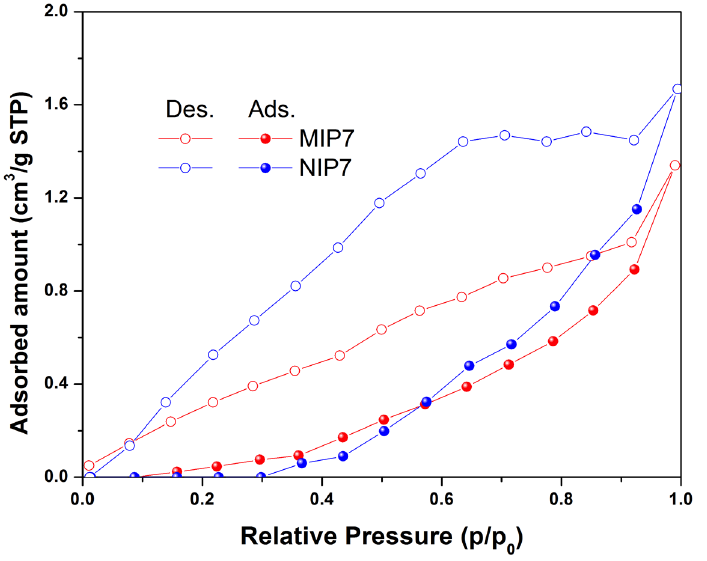
Figure 3. Nitrogen adsorption–desorption isotherms of MIP7 and NIP7 at 77 K.